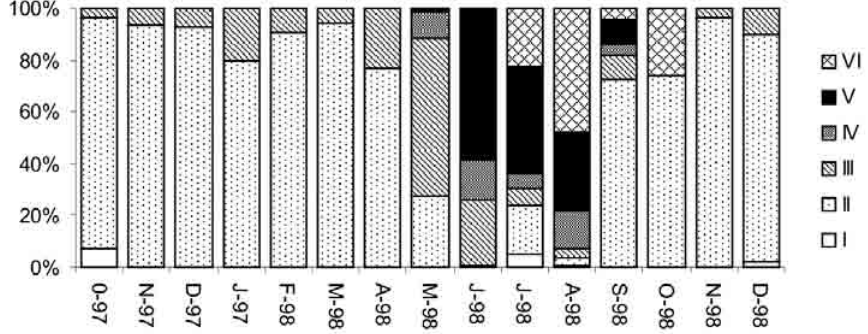
F IG . 8. – Monthly variation of the maturity stages L. mormyrus in the Thracian Sea. 10 years old. Individuals with a total length up to